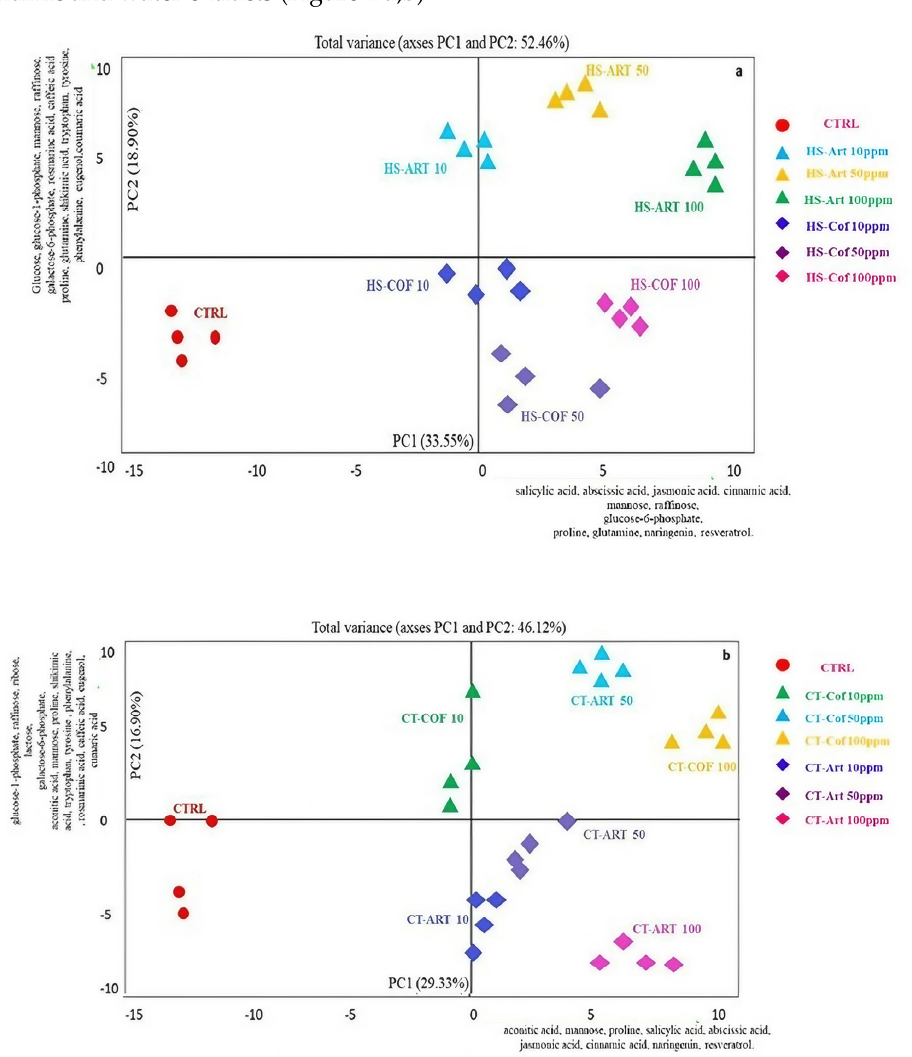
Figure 4. PCA score-plot based on untargeted metabolomics data obtained using Liquid Chromatography High Resolution Mass Spectrometry (LC-HRMS) of basil leaf extracts treated with humic substances ( a ) and compost teas ( b ) from artichoke and coffee grounds composted vegetable wastes (HS-ART, HS-COF, CT-ART, CT-COF) at different doses (10, 50, 100 g L − 1 ). Names and directions of most significant PCA loading vectors involved in the differentiation of treatments are reported along the score-plot borders. The PCA scores represent the single value of four different biological replicates.